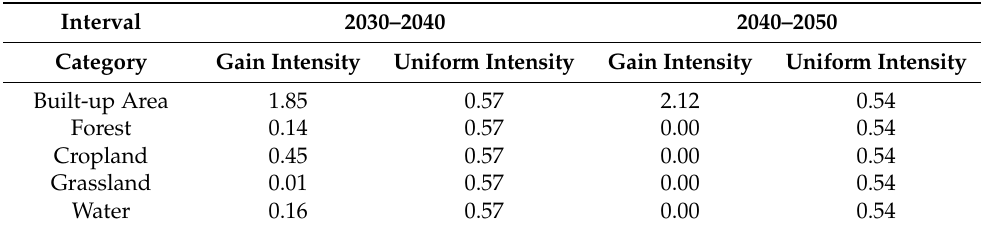
Table 25. Category-level Gain